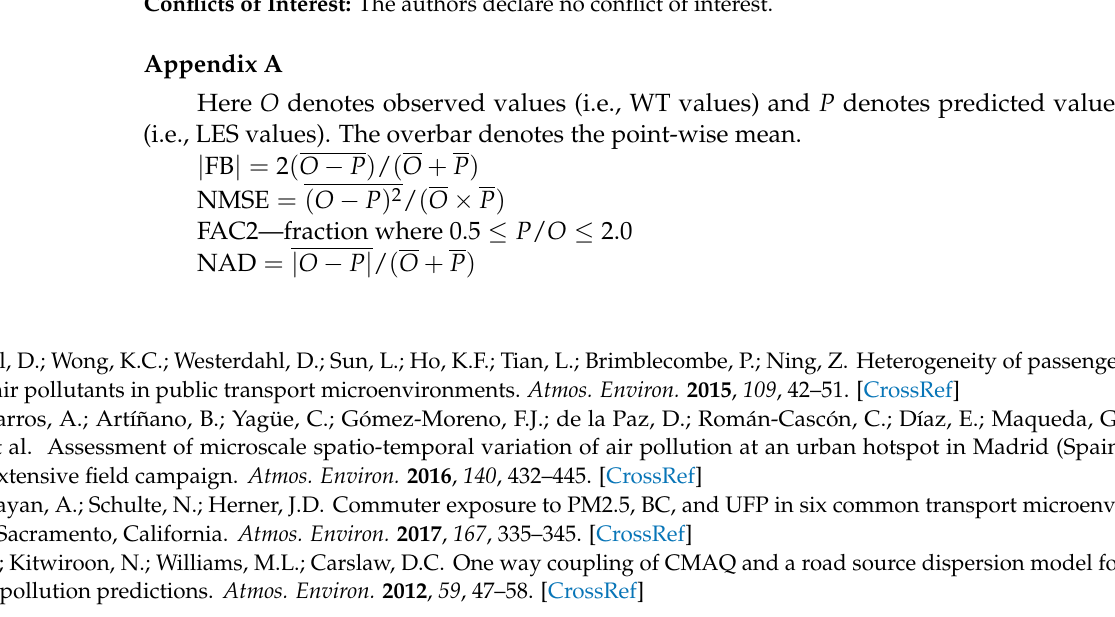
Figure S2: Illustration of derivation of the allowed absolute deviation, W; Figure S3: Wind roses showing the roadside wind speed and direction; Figure S4: Average velocity vortices at street level (Z = 1 m) as modelled by the LES for Day